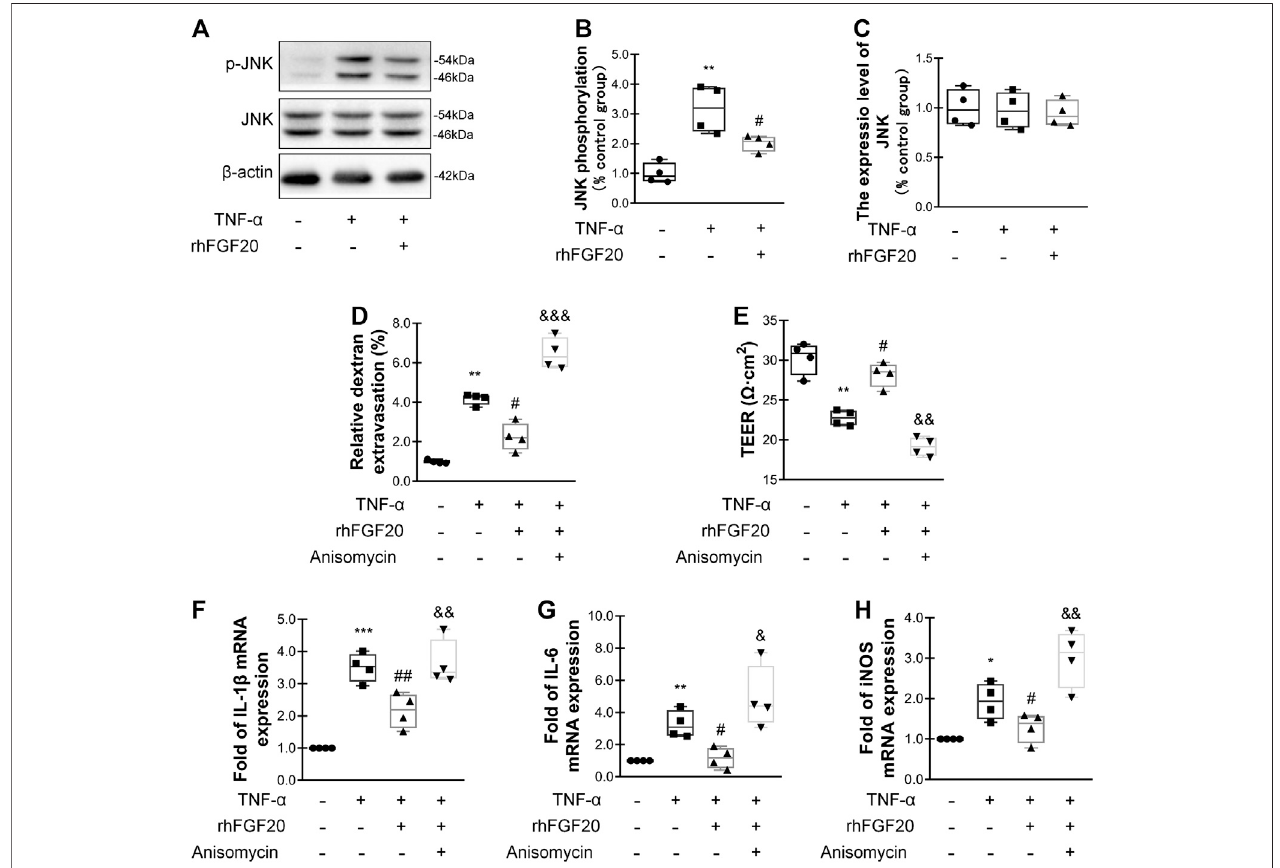
FIGURE 9 | rhFGF20 ameliorated HBMEC monolayer disruption by inhibiting the in fl ammatory response via the JNK/NF κ B signaling pathway (A) Effects of rhFGF20 on p -JNK and JNK levels, as shown by western blot analysis, with β -actin used as the loading control and for band density normalization (B – C) Effects of rhFGF20 on p -JNK and JNK protein levels, as analyzed by quanti fi cation of western blot data ( n (cid:1) 4) (D – E) The JNK agonist anisomycin (20 μ M) reversed the rhFGF20- mediatedrescueofchangesinFITC-dextrantransportanddecreasedendothelialresistance( n (cid:1) 4) (F – H)